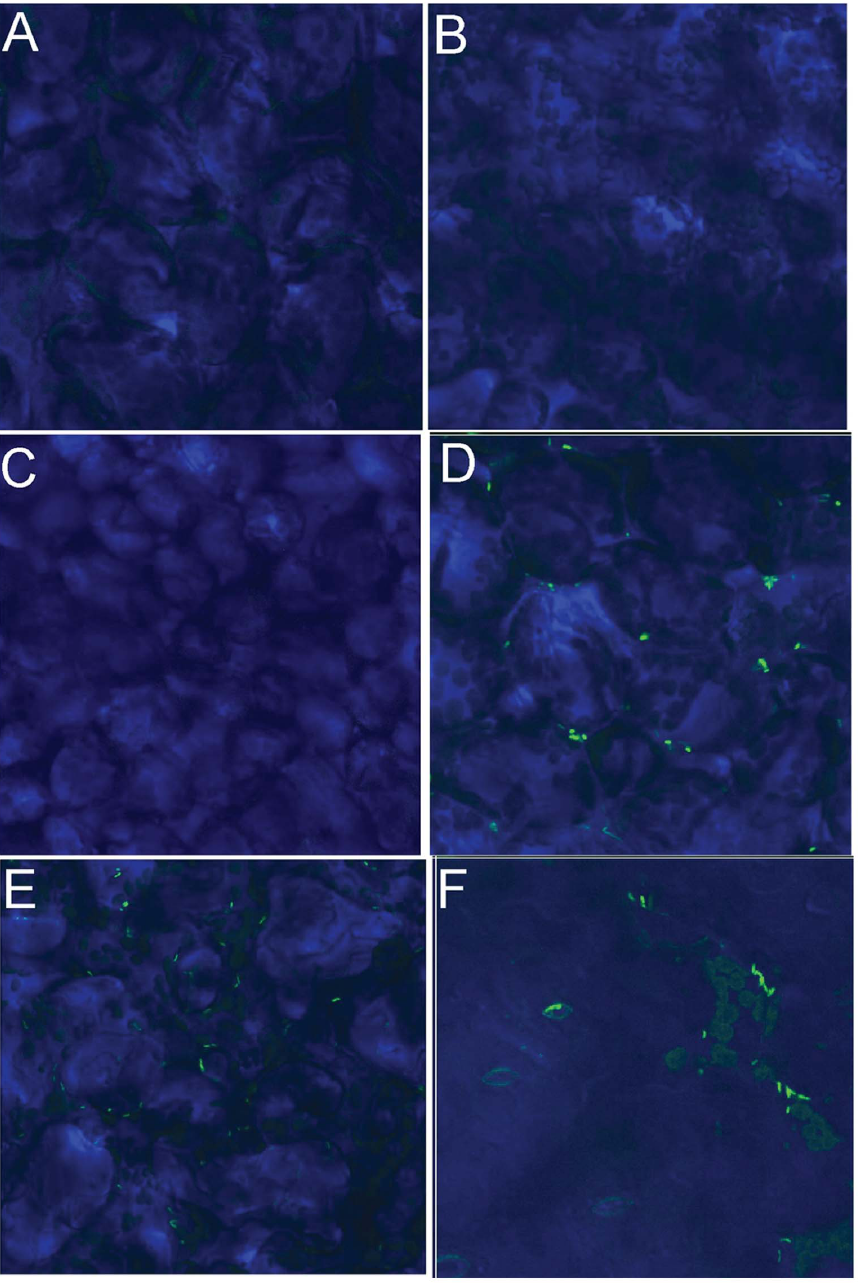
Figure 1. Confocal microscopy images at a magnification of 650X of A.thaliana Col-0 mesophyll cells 7 hours after infection with P. carotovorum. A. Mesophyll cells from an uninoculated leaf. B. Mesophyll cells from a leaf inoculated with WPP14. C. Mesophyll cells from a leaf inoculated with WPP14 D h rpL (pDFI:: dspE pro GFP) as a negative control. D. Mesophyl cells from a leaf inoculated with 200 mM arabinose and WPP14(pDFI:: dspE pro GFP) and pBAD:: hrpL as a positive control. E and F . Mesophyl cells infected with WPP14 (pDFI:: dspE pro GFP). Images are representative of three independent experiments in which at least one leaf was inoculated for each